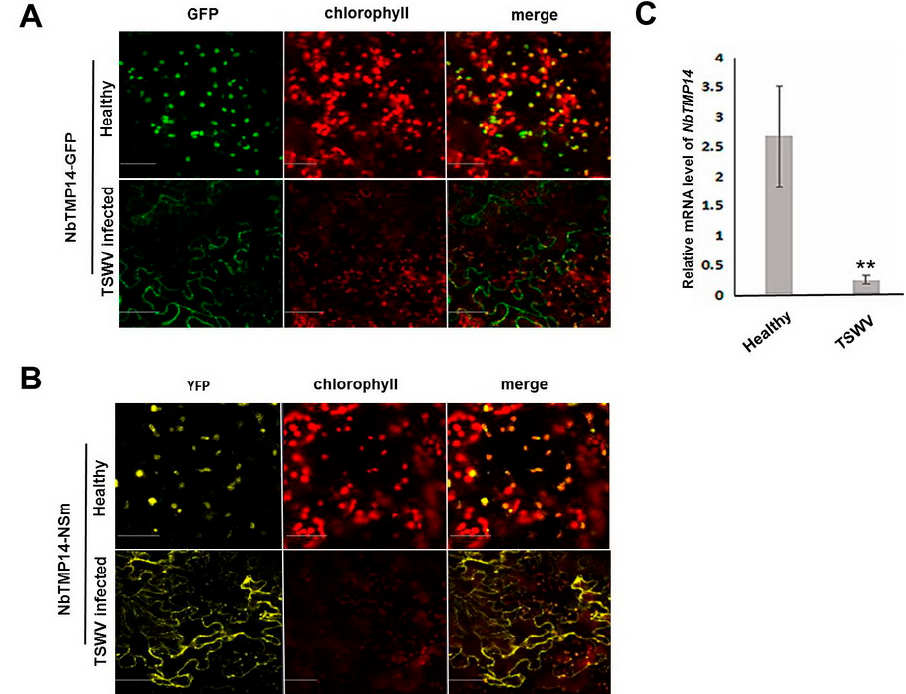
Figure 3. NbTMP14 expression and subcellular localization were disturbed by TSWV infection. ( A ) The subcellular localization of NbTMP14 was compared between healthy and TSWV-infected plants at 10 dpi. Scale bars represent 100 µ m. ( B ) The interaction site of NbTMP14/NSm was compared between healthy and TSWV-infected plants. Scale bars represent 100 μ m. ( C ) The expression levels of NbTMP14 were compared between healthy and TSWV-infected plants; NbTMP14 was significantly downregulated after viral infection. Bars represent the mean ± standard error, ** indicates the significant differences (Student’s t -test, ** p < 0.01).